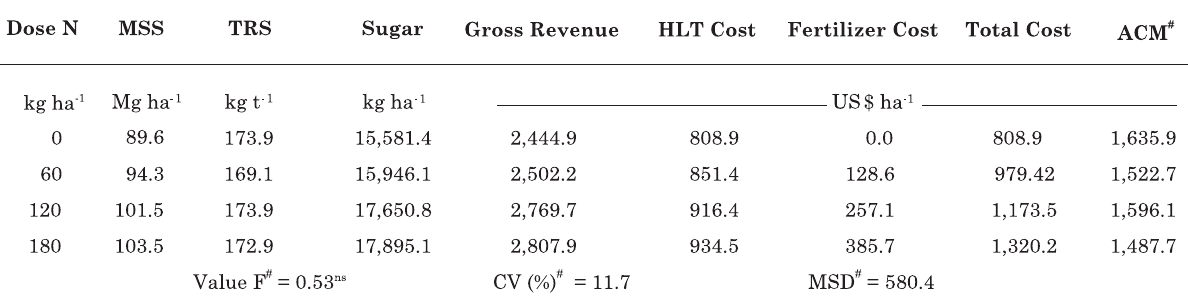
Table 2. Agricultural contribution margin (ACM) in terms of nitrogen fertilization in the second ratoon cycle of sugarcane